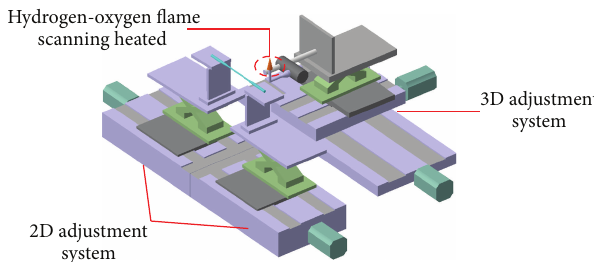
Figure 4: The illustration of microfiber drawing method using flame-heated scanning technique. The single-mode optical fiber is placedintotheplacesuitabletemperatureofhydrogen-oxygenflame using 3D translation systems. Single-mode fiber is drawn down to microfiber based on the